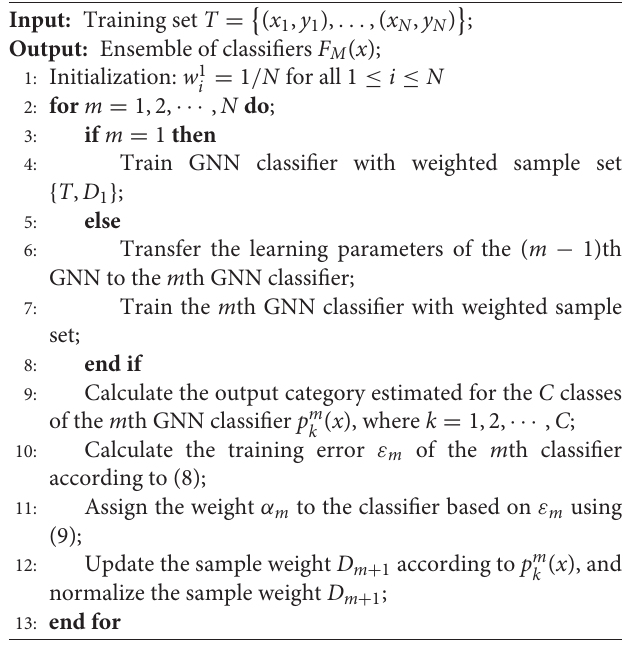
Algorithm 1 Framework of the Boosting-GNN algorithm.